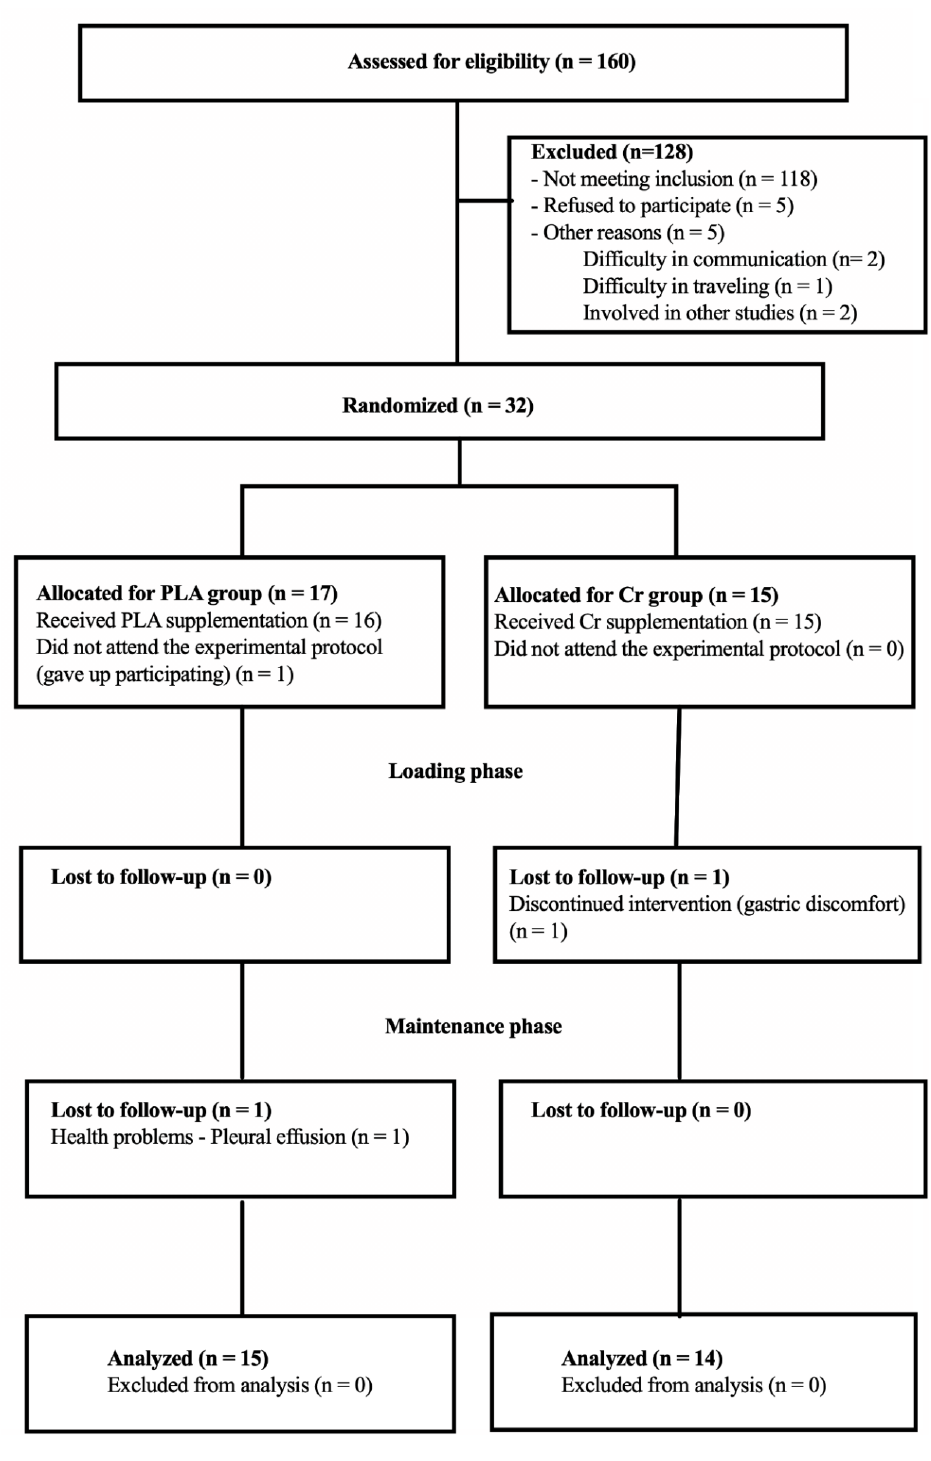
Figure 2. Study flow.